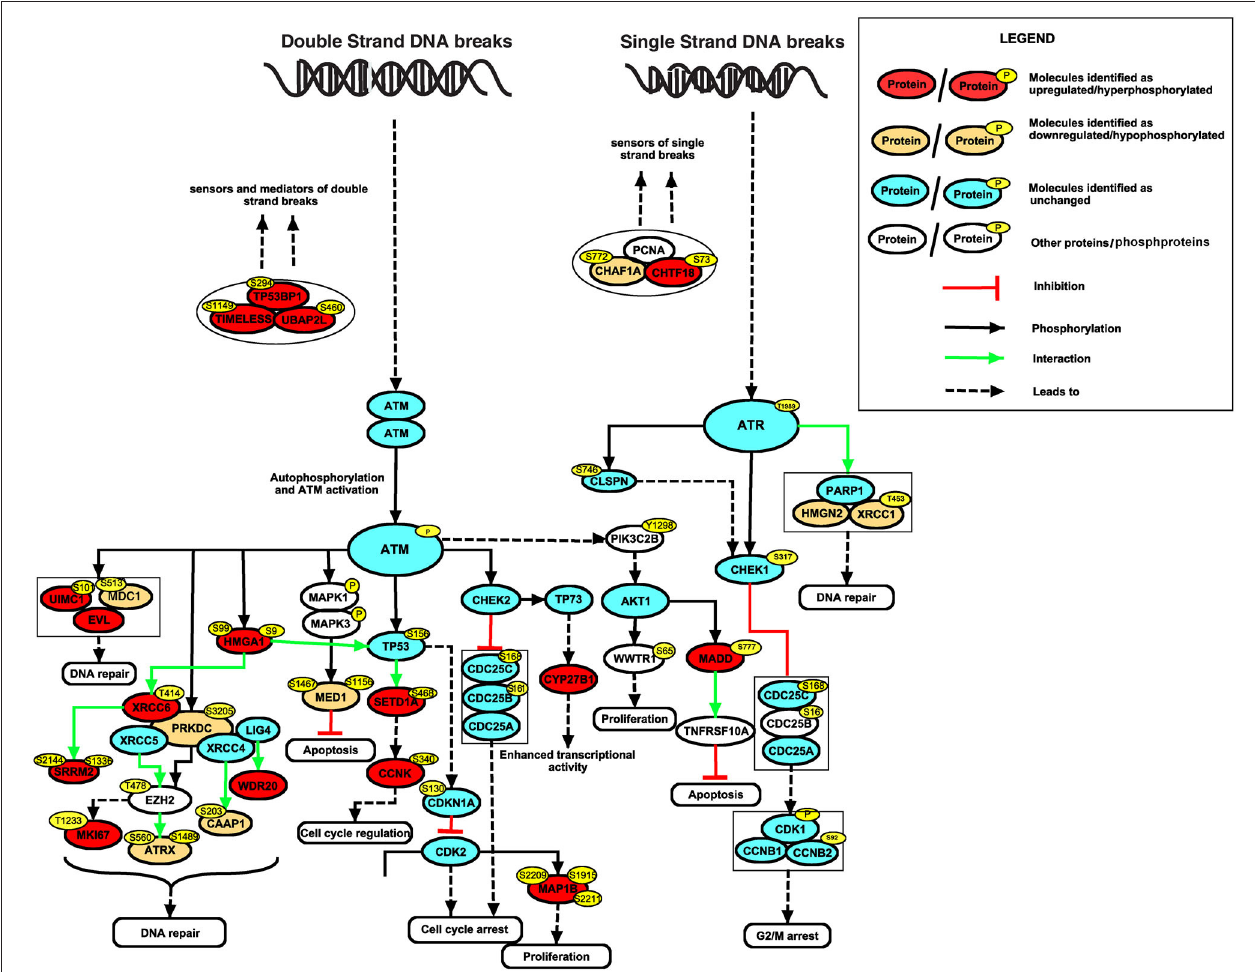
FIGURE 4 | Alteration in DNA repair mechanism in esophageal cells chronically treated with cigarette smoke condensate. Signaling network of DNA damage and repair pathway identified based on differentially expressed proteins and phosphoproteins in CSC treated cells.